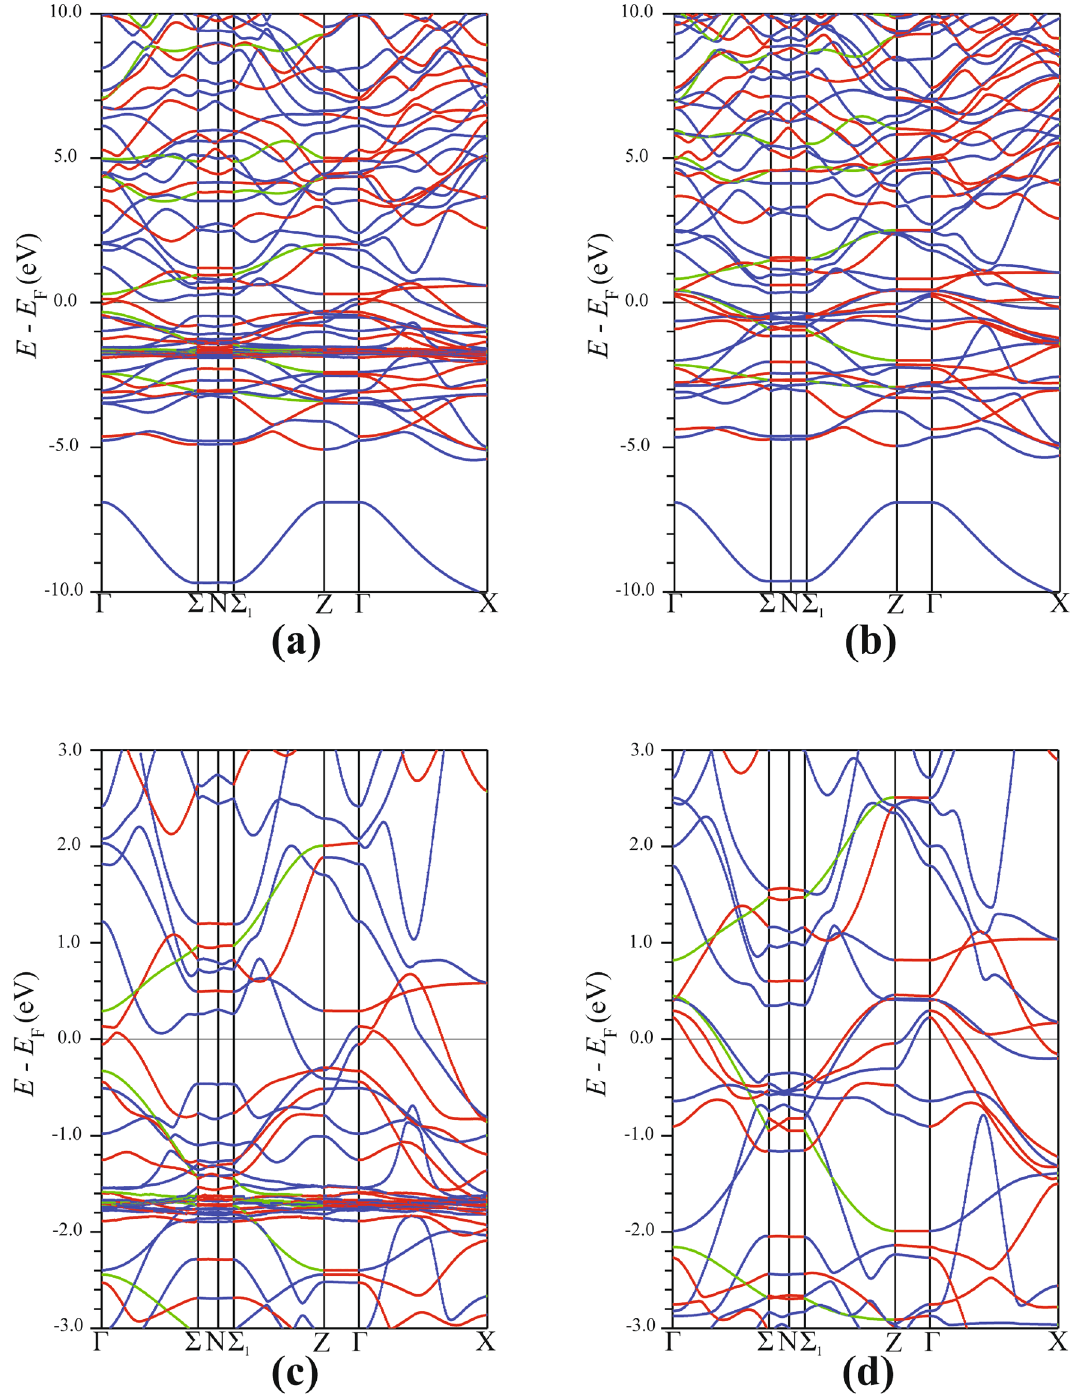
Figure 7. Spin-polarized band structure of EuFeAs 2 in the high-symmetry directions of the conventional Brillouin zone. The spin-up ( a ) and spin-down ( b ) band structure in the energy range between − 10 and 10 eV. The spin-up ( c ) and spin-down ( d ) band structure close to the Fermi level. SigmaPlot v14, www. systa tsoft ware.